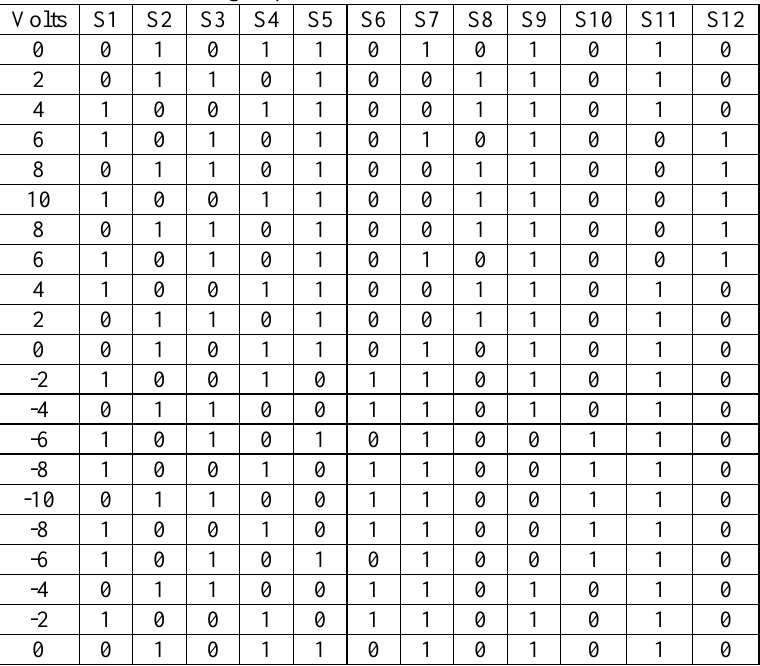
Table 4: Switching sequences for the 11-level multilevel inverter.